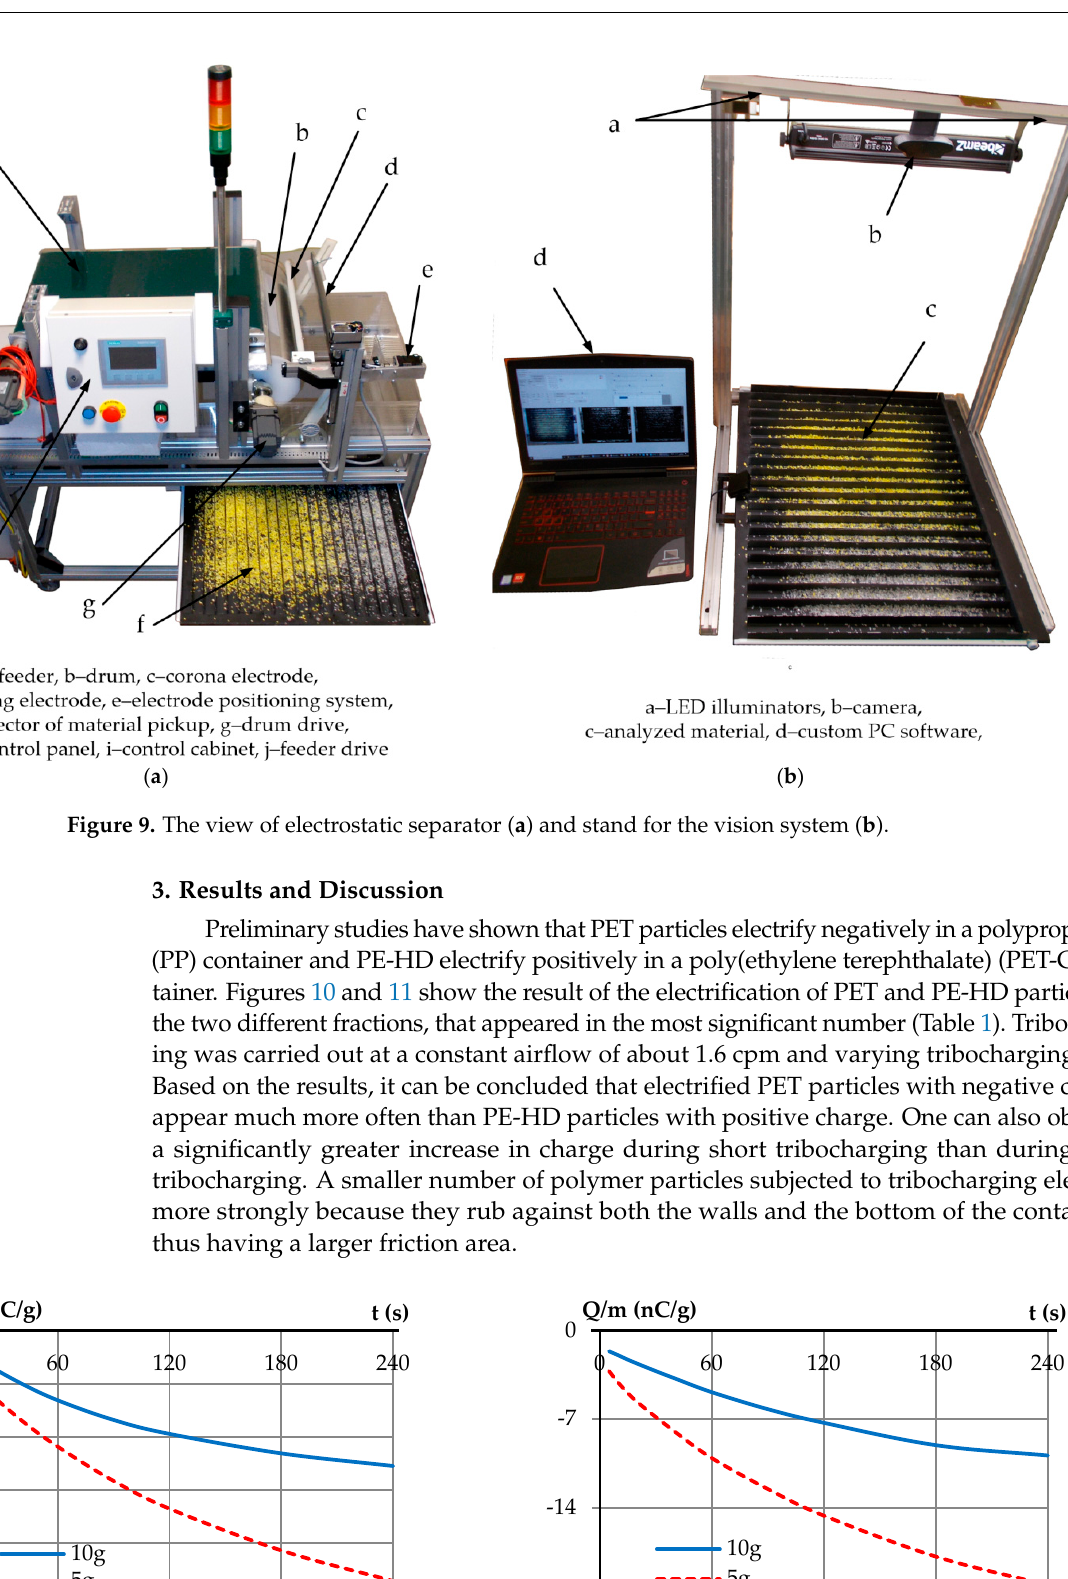
( b ) Figure 11. Charge density per mass as a function of time t tribocharging in a PET-G container for PE-HD with fraction ( a ) 1.8–2.8 mm and ( b ) 2.8–4 mm at airflow V = 1.6 cpm. In further experiments, the impact of different airflows while maintaining a constant tribocharging time of t = 30 s was examined. Selected results of the charging of particles in both materials for four fractions are summarized in Figure 12. Based on the analysis of the obtained results it can be concluded that the increase in the airflow during a tribo- charging process causes greater electrification of particles of both materials. Out of the fractions studied, particles with small dimensions (fraction 1.8–2.8 mm and <1.8 mm) are the most electrified ones. On the other hand, particles with larger dimensions (fraction above 4 mm) are quite difficult to electrify in both materials. Both increasing the time and increasing the airflow for tribocharging results in very uneven electrification of the par- ticles of both materials. Most of the particles are relatively weakly electrified 1–2 nC/g, however with a high airflow and long tribocharging time, a small number of particles become strongly electrified even above 50 nC/g. It was found that with a short time and lower airflow from the blower, the electrification of PET and PE-HD particles is quite uniform.